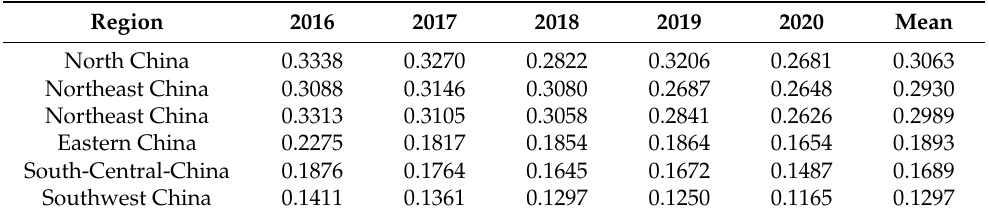
Table 2. Descriptive statistics of water vulnerability.